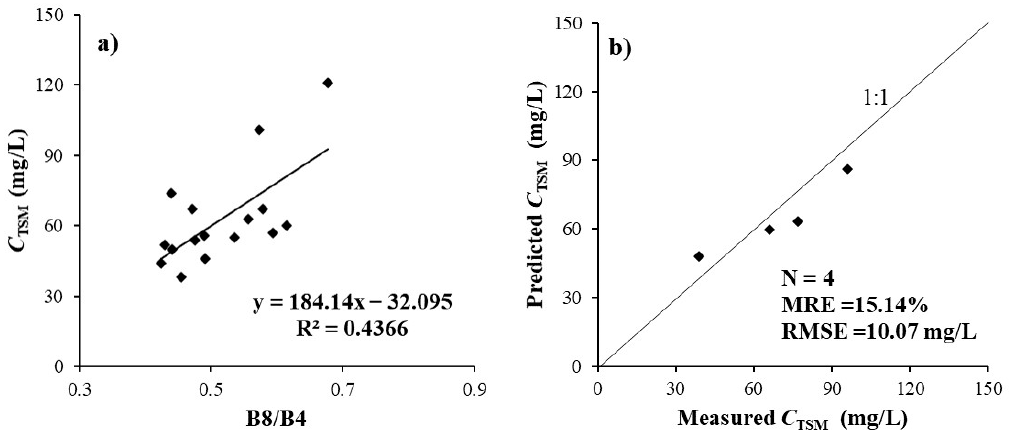
Figure 5. ( a ) The TSM concentration inversion model established by method 2, and ( b ) the accuracy evaluation of the model by verification samples.